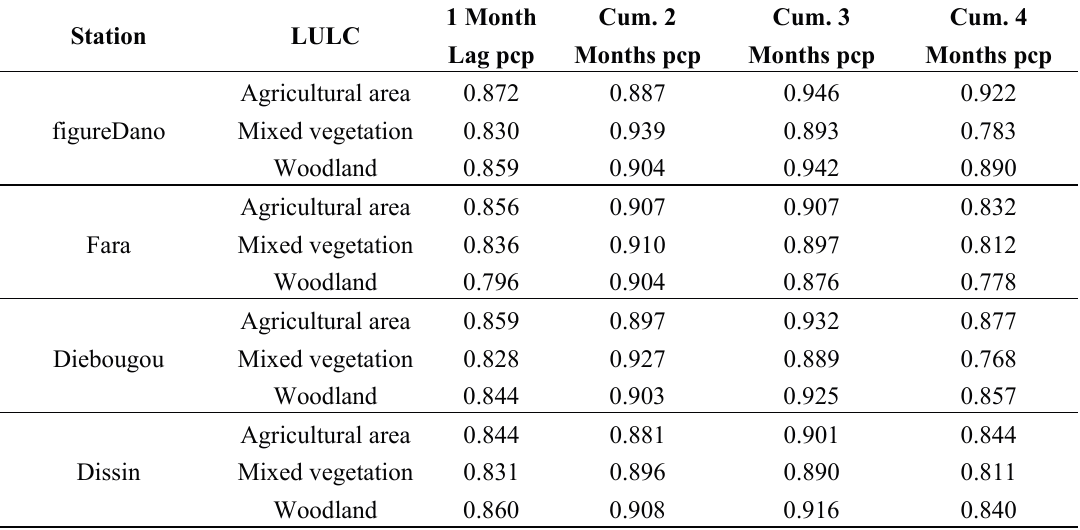
Table 5. Correlation between EVI of land use/cover types and rainfall variability indicators. Station LULC